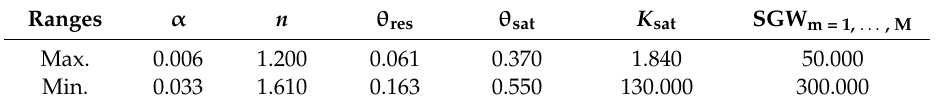
Table 1. Maximum and minimum parameter constraints used in the iteration algorithm (IA). Ranges α n θ res θ sat K sat SGW m = 1, ... , M Max. 0.006